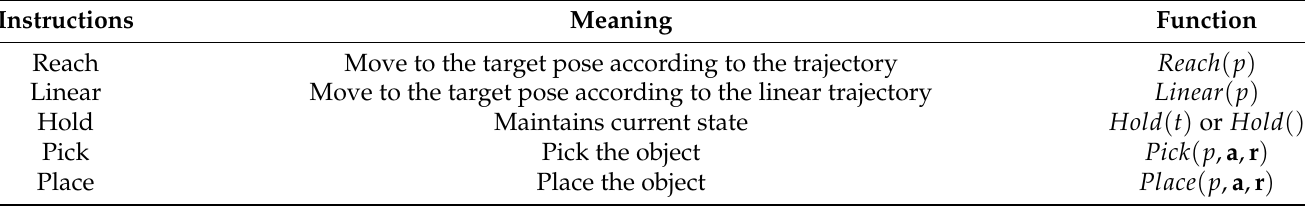
Table 1. Action instructions for planning